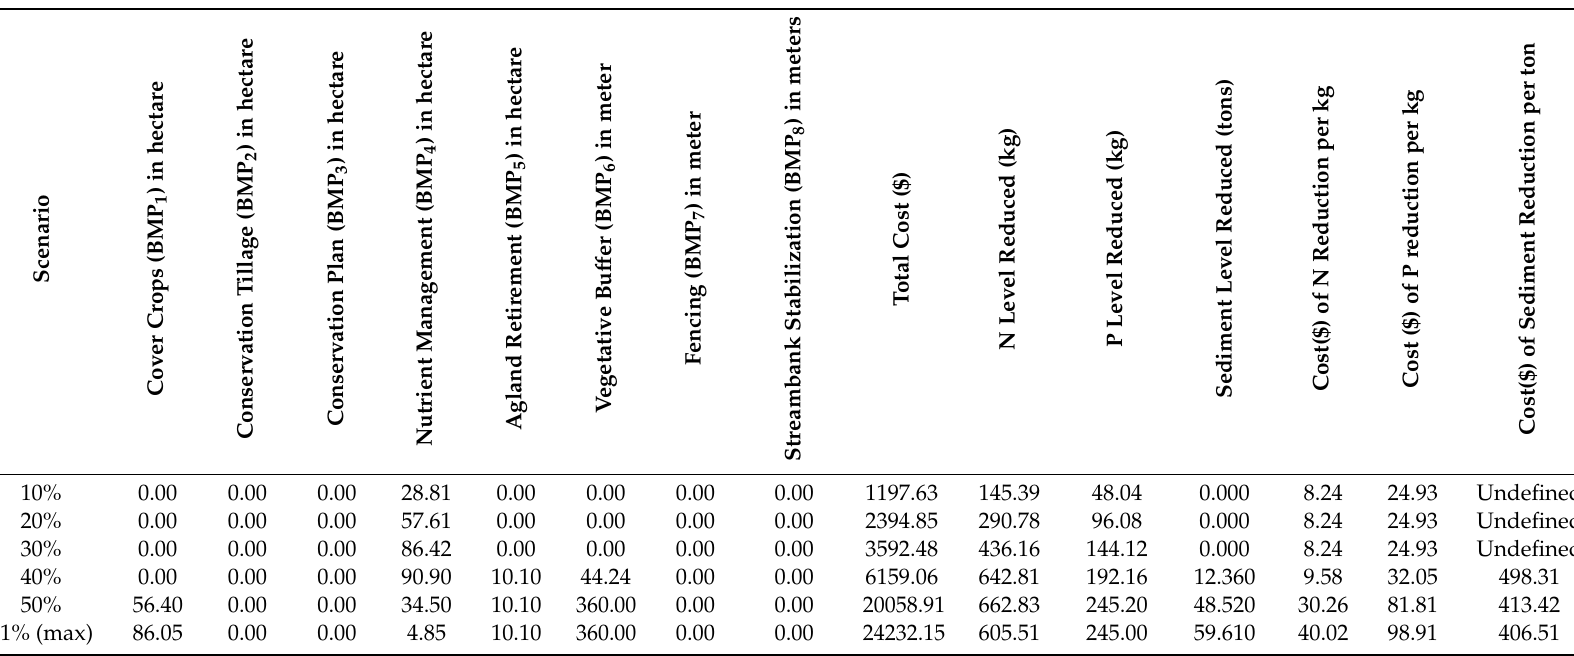
Table 4. Summary of best management practice (BMP) adopted area, total cost of pollutant reduction, and unit cost of nitrogen, phosphorus, and sediment reductions under alternative weather scenarios in the Saline Bayou watershed (normal weather scenario